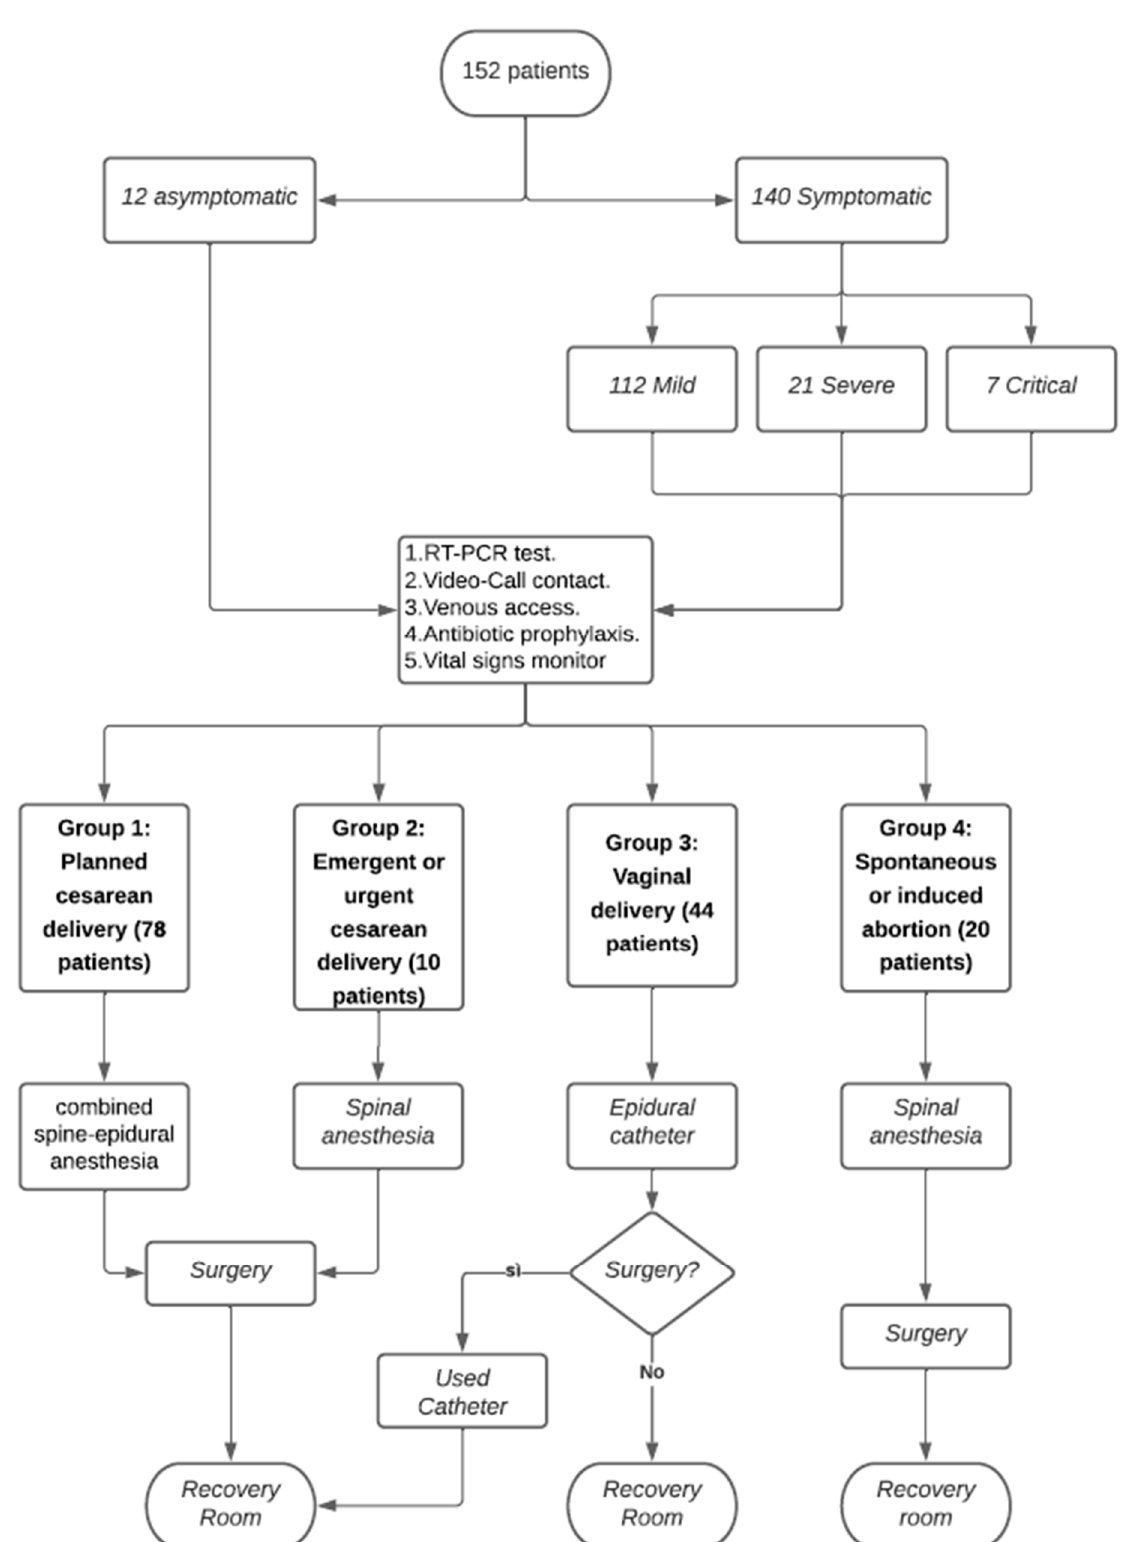
Figure A1. Flow Figure A1. Flow chart.